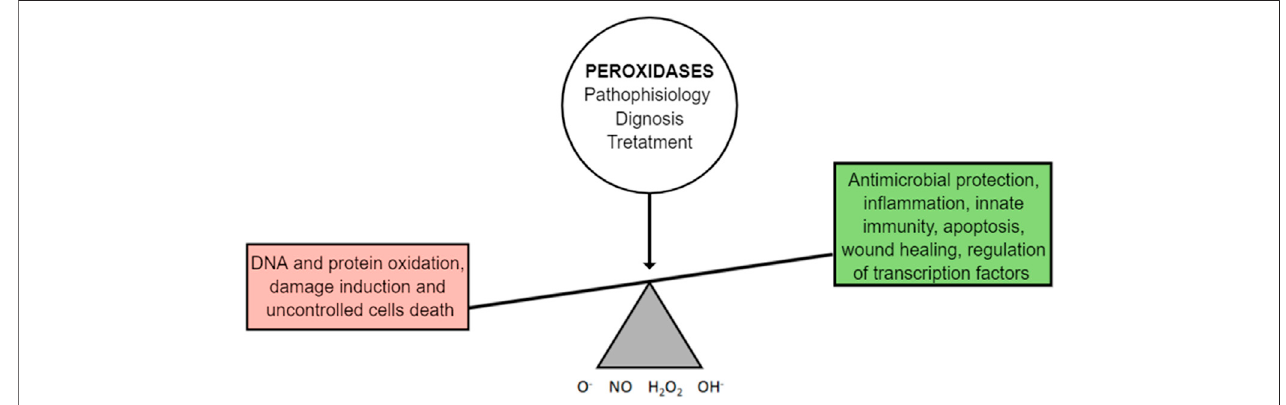
FIGURE 3 | OS is an integrated mechanism of the biological functions and the mechanisms of the diseases. It involves caloric restriction and body synergism with its micro fl ora.